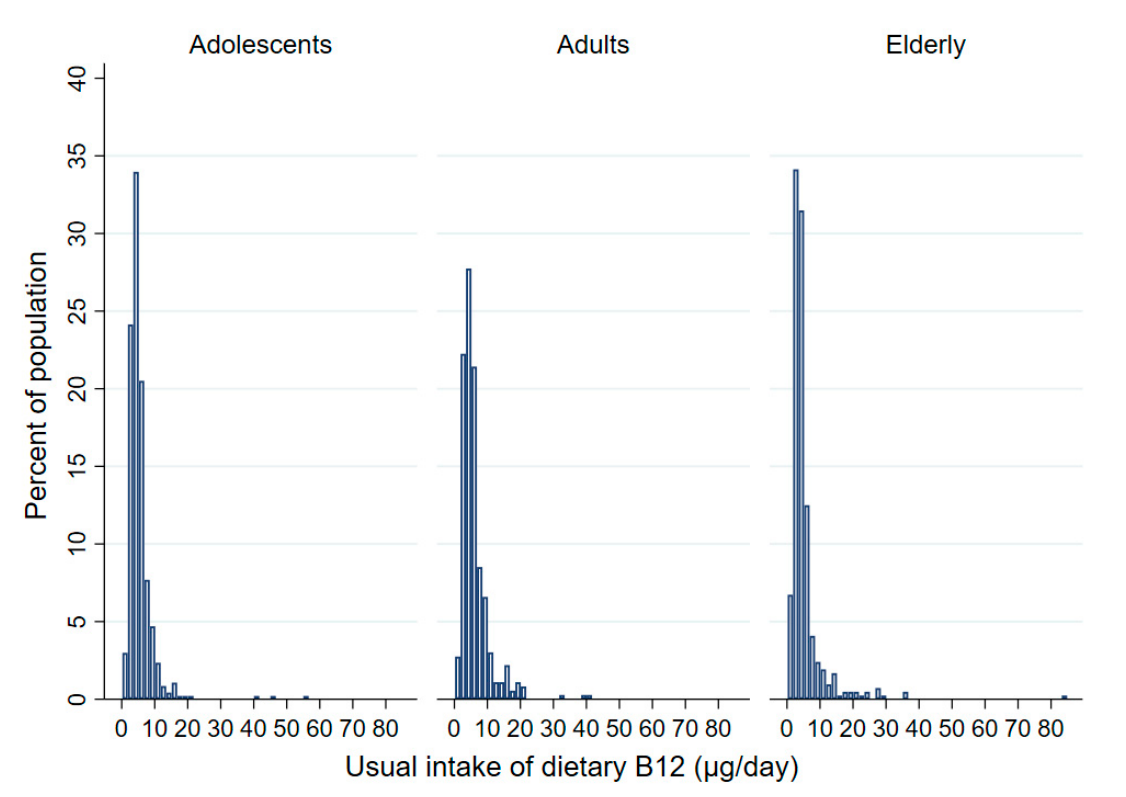
Figure 1. Histograms of the sample population distribution of estimated usual daily intake of vitamin B12 for different age groups (adolescents: 10–17 years; adults: 18–64 years; elderly: 65–74 years).